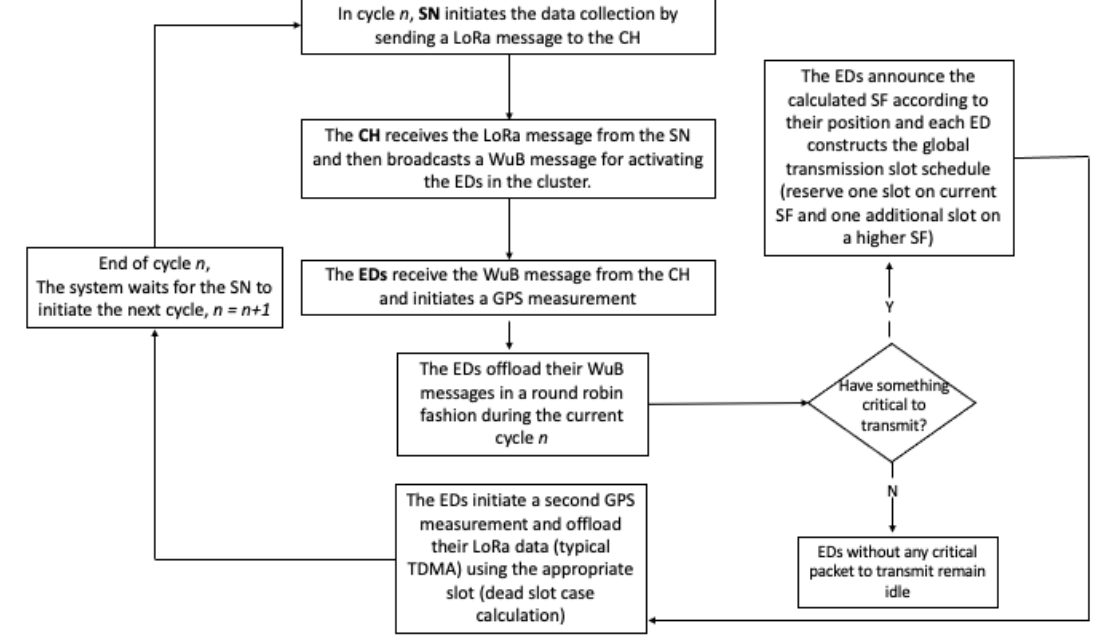
Figure 2. Sequence diagram of the proposed MOTILO